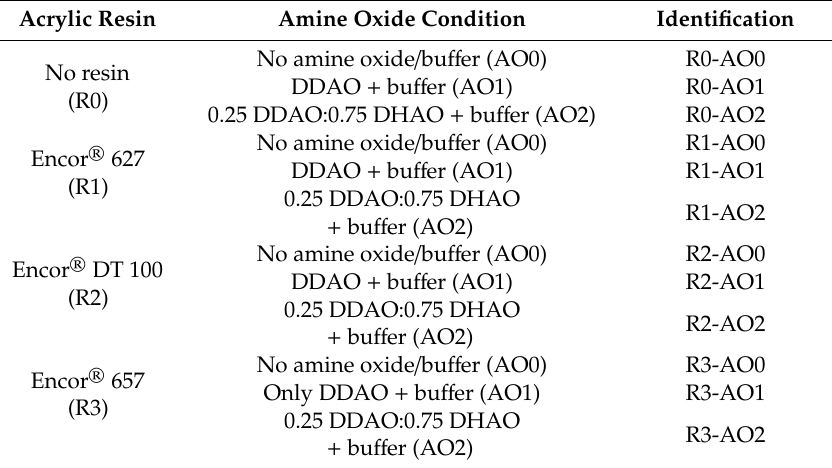
Table 2. Configuration and identification of the